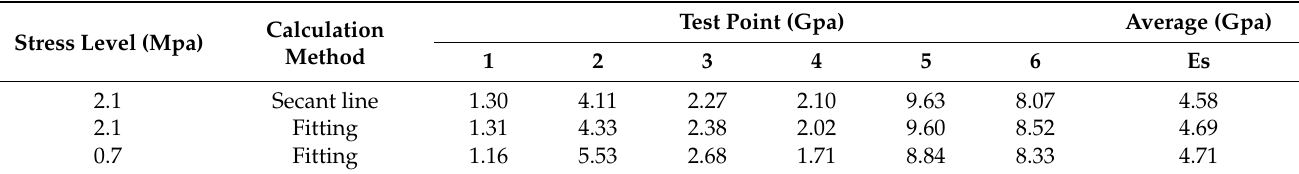
Table 1. Deformation modulus of each test point.